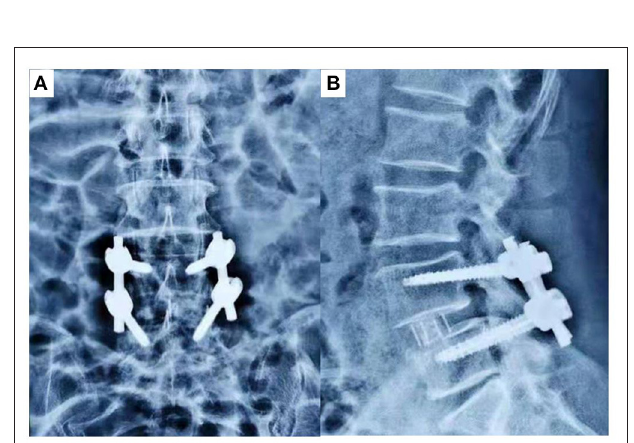
FIGURE 3 | (A) Anterior and (B) lateral radiographs of a patient at 3 months